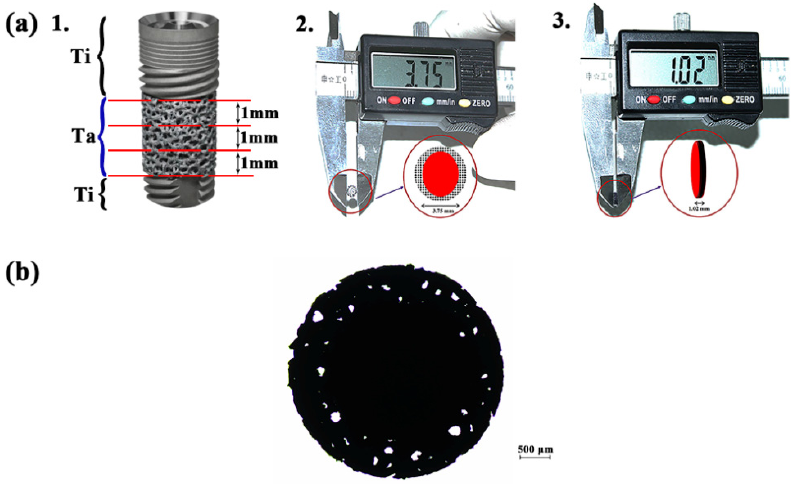
Figure 1. Porous tantalum trabecular metal (PTTM) implant. ( a ) 1. The Ta from the center of the PTTM implant was sectioned into three slices of 1 mm each. 2. The diameter of the Ta Disc. 3. The size of the Ta disc as measured by a vernier caliper. ( b ) Ta disc under the polarizing microscope shows holes where light can pass through, representing interconnectivity.